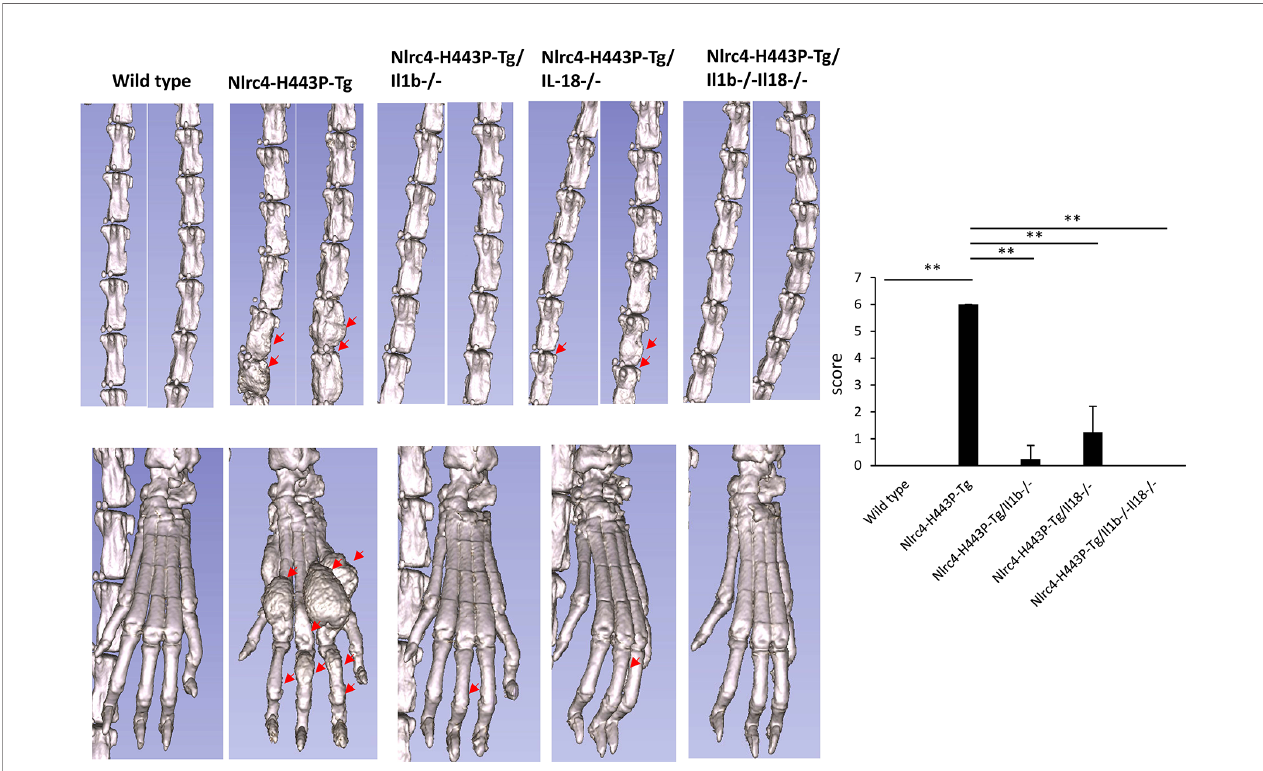
FIGURE 3 | IL-1 b – and Il-18 – mediated bone deformity in Nlrc4-H443P-Tg mice. The tail and left foot in control, Nlrc4-H443P-Tg, Nlrc4-H443P-Tg/Il1b − / − , Nlrc4- H443P-Tg/Il18 − / − , and Nlrc4-H443P-Tg/Il1b − / − Il18 − / − mice at the age of 20 weeks were evaluated with m CT. Red arrows, bone deformity regions (N = 5 in each group). The scores were evaluated as shown in the Materials and Methods in control, Nlrc4-H443P-Tg, Nlrc4-H443P-Tg/Il1b − / − , Nlrc4-H443P-Tg/Il18 − / − , and Nlrc4-